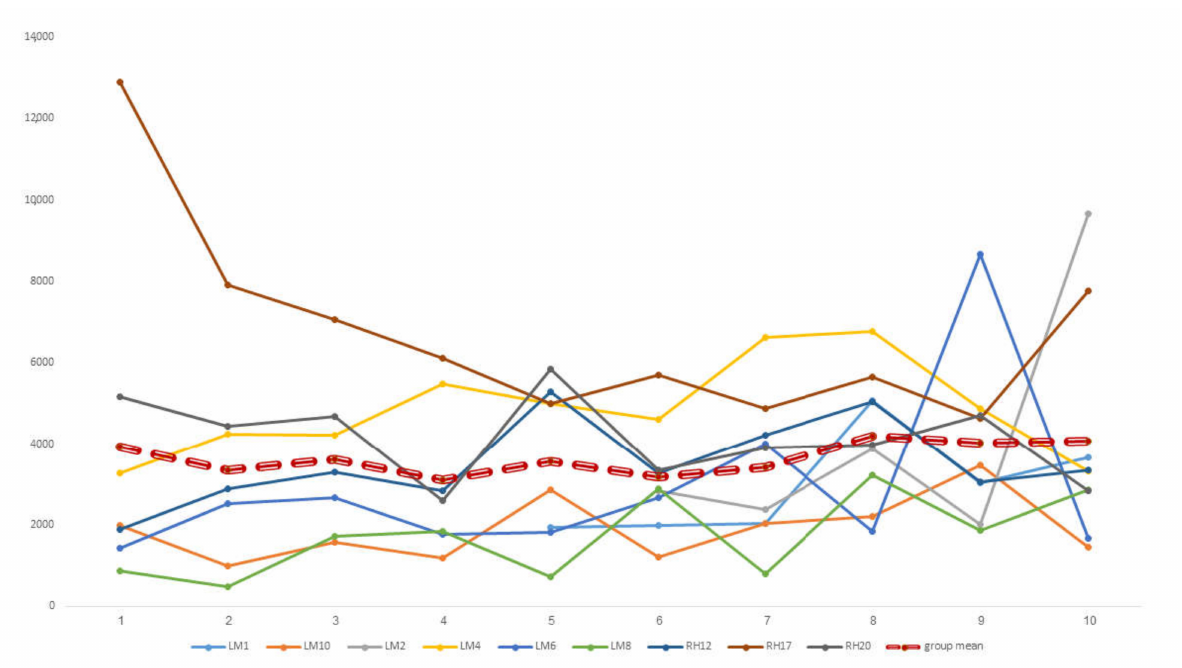
Figure 3. Upregulating alpha automatic scoring for each participant during each of the ten sessions, and the group mean (bold dotted line). Note: missing data for one subject;